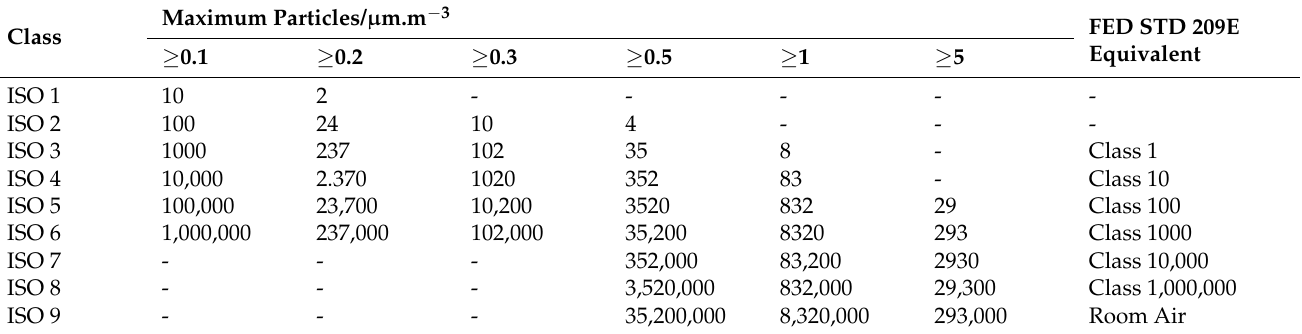
Table 1. ISO 14644-1 cleanroom standards